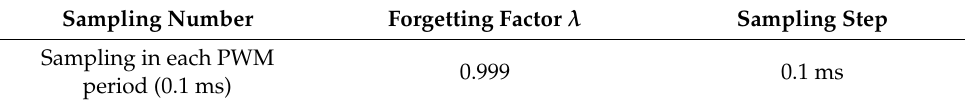
Table 2. Details of RLS algorithms.